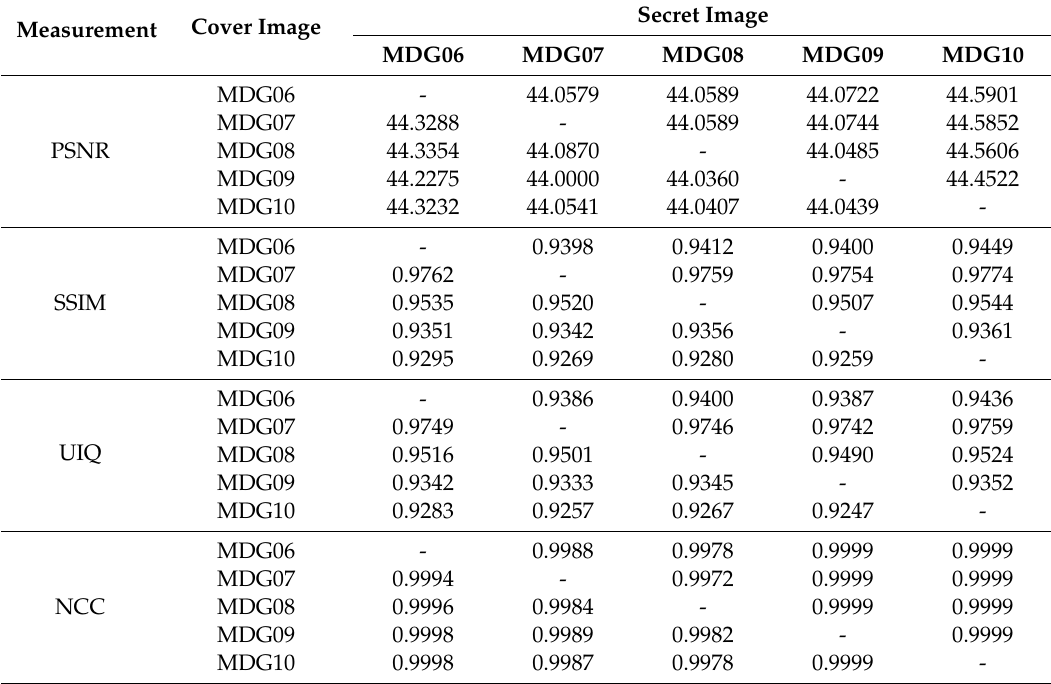
Table 3. PSNR, SSIM, UIQ, NCC, NAE, IF, AD, MD, and SC values for greyscale images used in the experiments